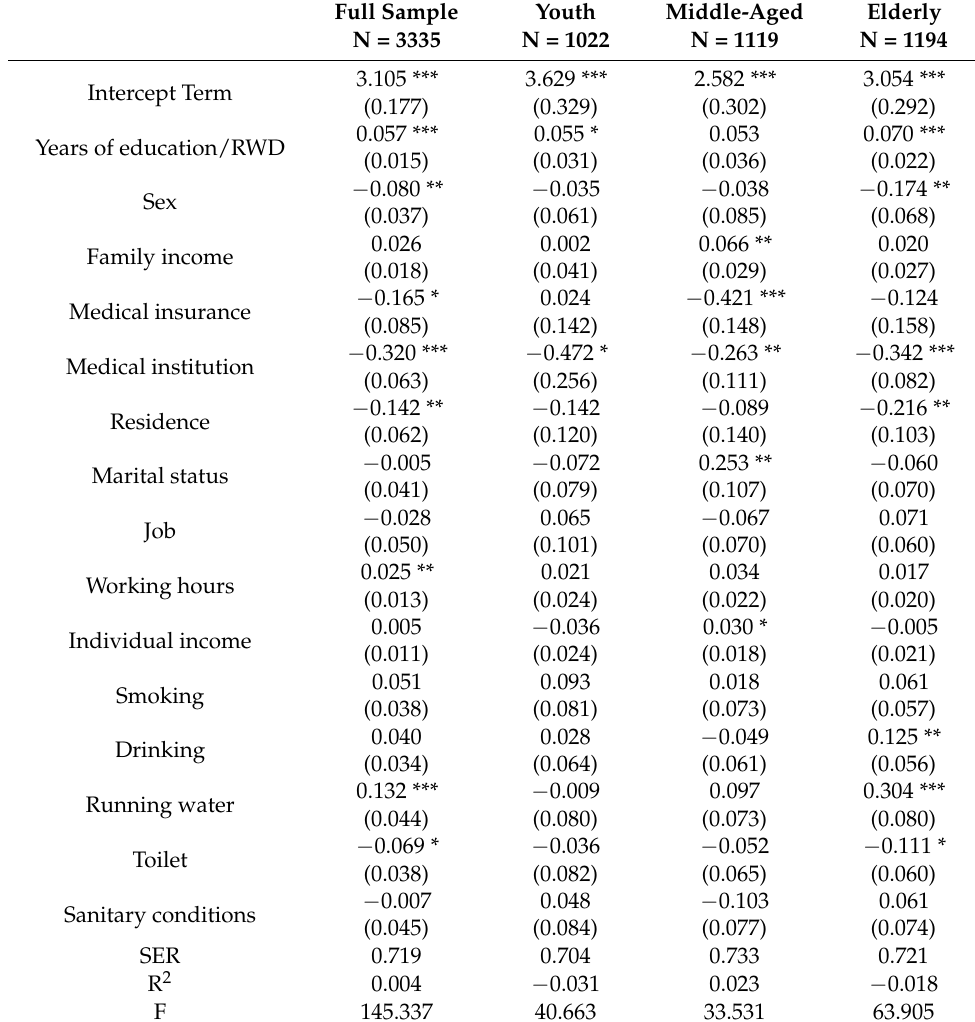
Table 5. Results of two-stage least squares (by age, for physical